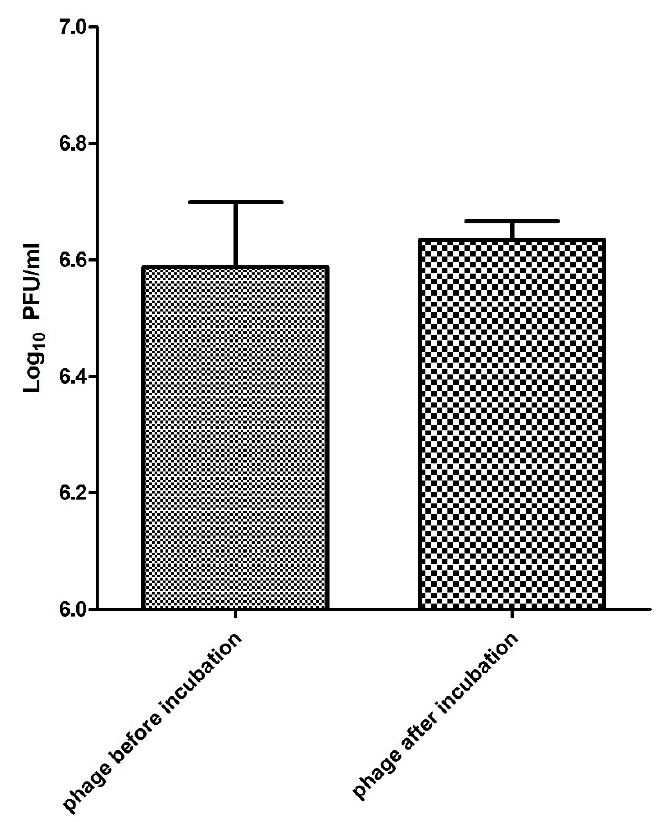
Figure 5. Displays the phage stability against AgNPs after incubation for 4